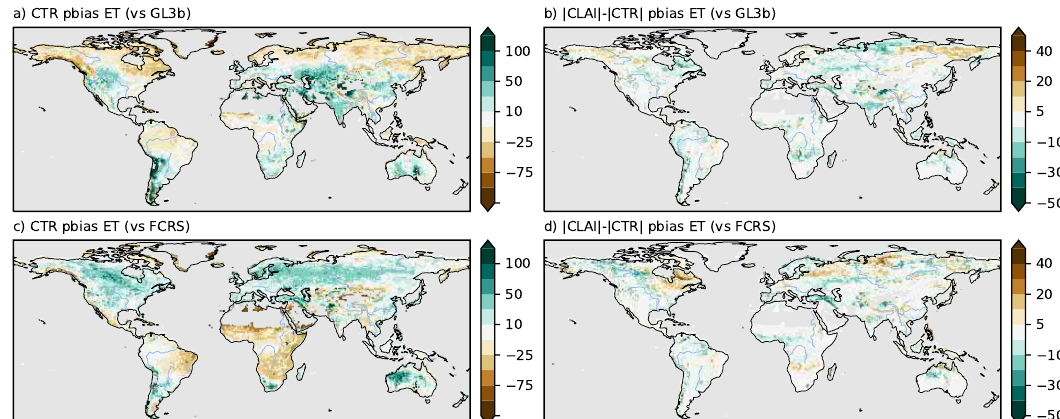
Figure 10. Annual mean evapotranspiration relative bias (%) with respect to GLEAM ( a ) and FluxCom ( c ); and the absolute relative bias difference (%) between the ESA-CCI + LAI (CLAI) experiment and the control experiment (CTR), where GLEAM is used for verification in ( b ) and FluxCom in ( d ). Note the different range of the color-bars between ( a , c ) ( − 100 to 100) and ( b , d ) ( − 50 to 50).